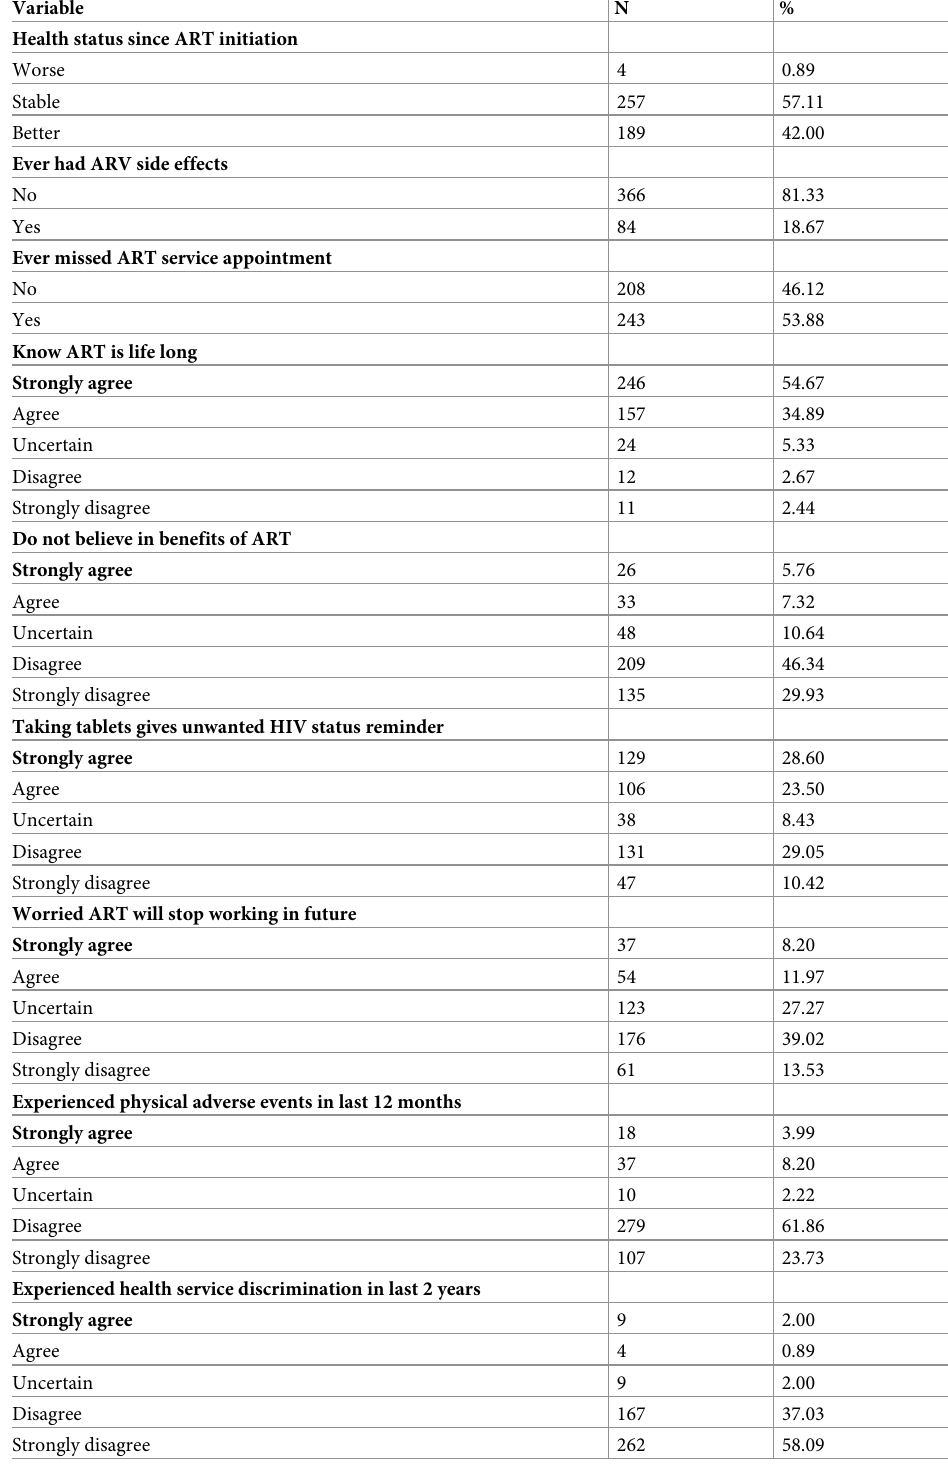
Table 3. Participants’ knowledge, experiences and views about